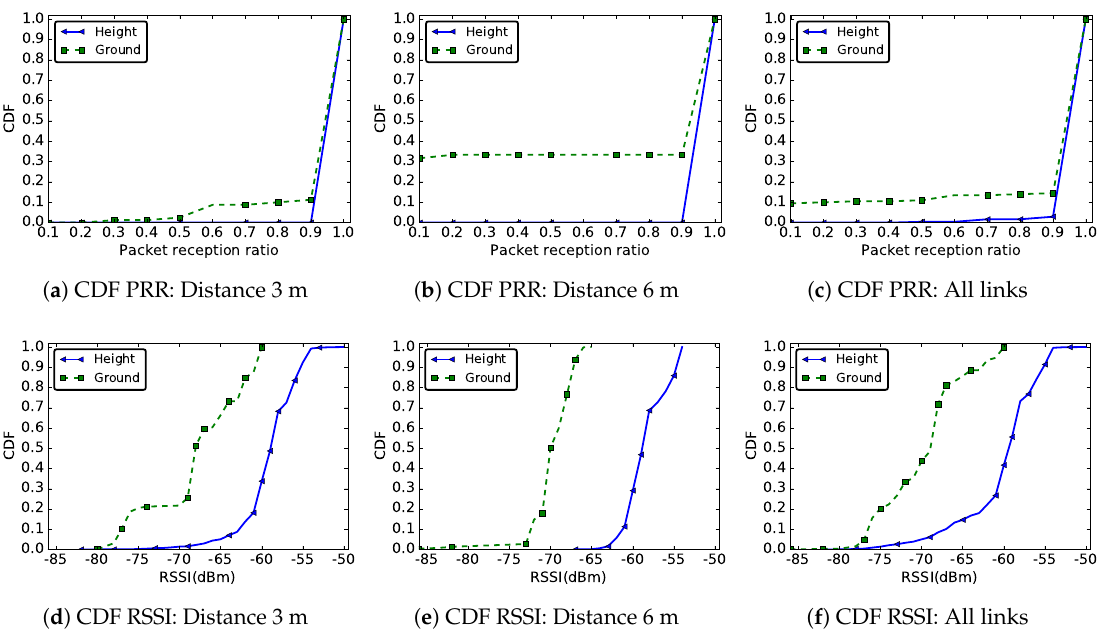
Figure 6. CDF of PRR and RSSI for distances 3 m and 6 m and for all links in the network in two different deployments: sensors deployed at ground level and sensors deployed on a support of height 57 cm.